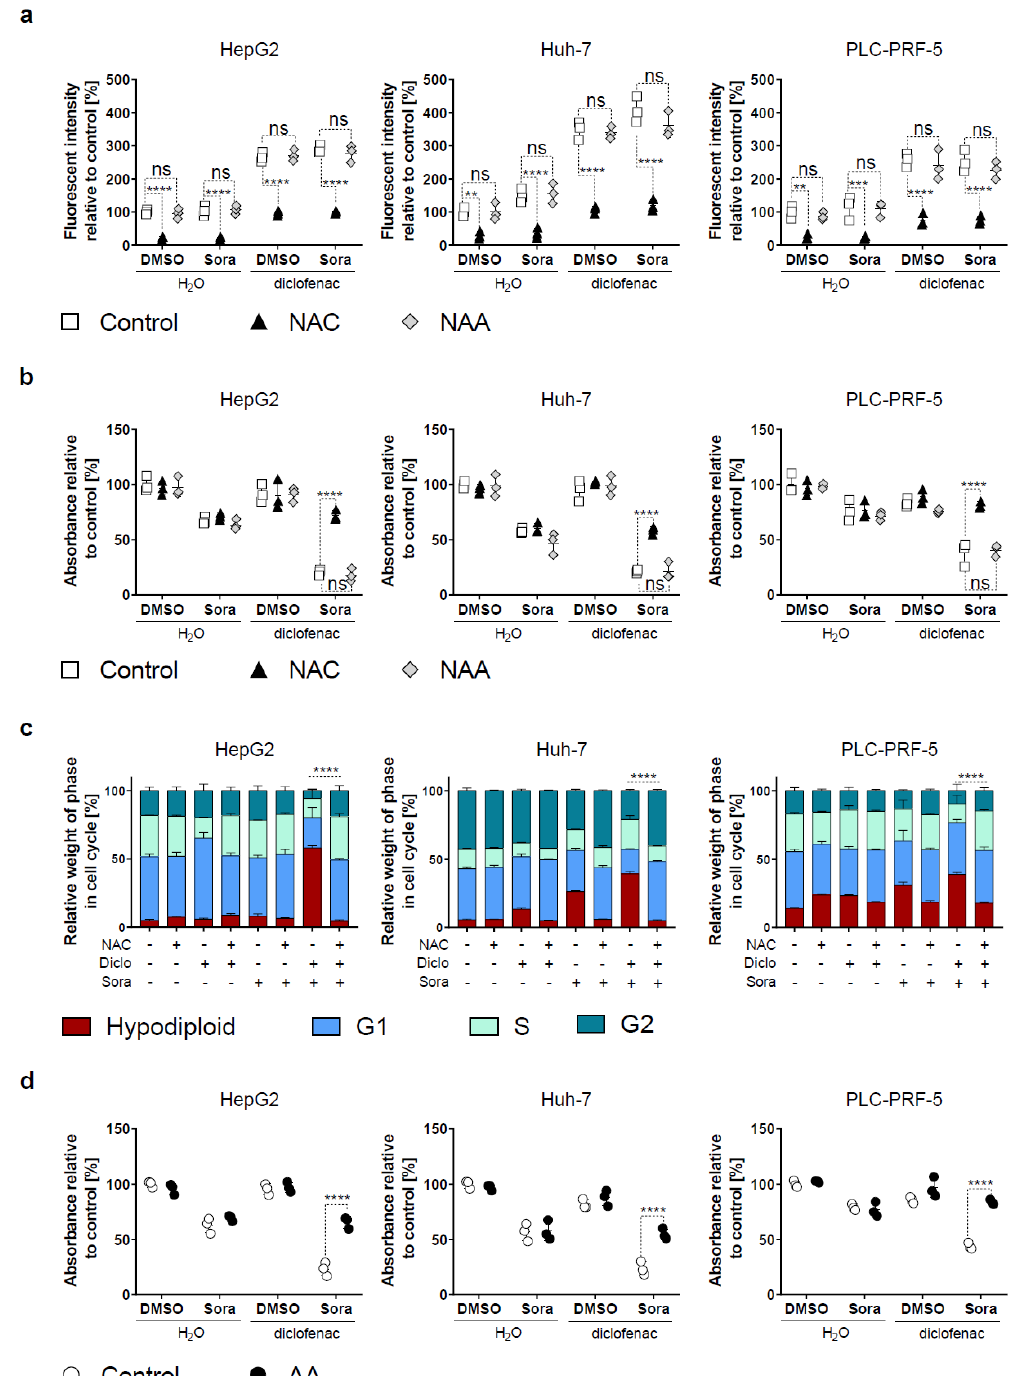
Figure 3. Sorafenib/diclofenac-induced HCC cell death is prevented by anti-oxidants. ( a ) HCC cells were treated with sorafenib (Sora, 5 µ M) or diclofenac (100 µ M), or DMSO or H 2 O as controls, for 5 h in the presence or absence of N-acetyl-cysteine (6 mM, NAC) or N-acetyl-alanine (6 mM, NAA). ROS levels were determined and expressed as mean fluorescent intensity relative to control (DMSO/H 2 O